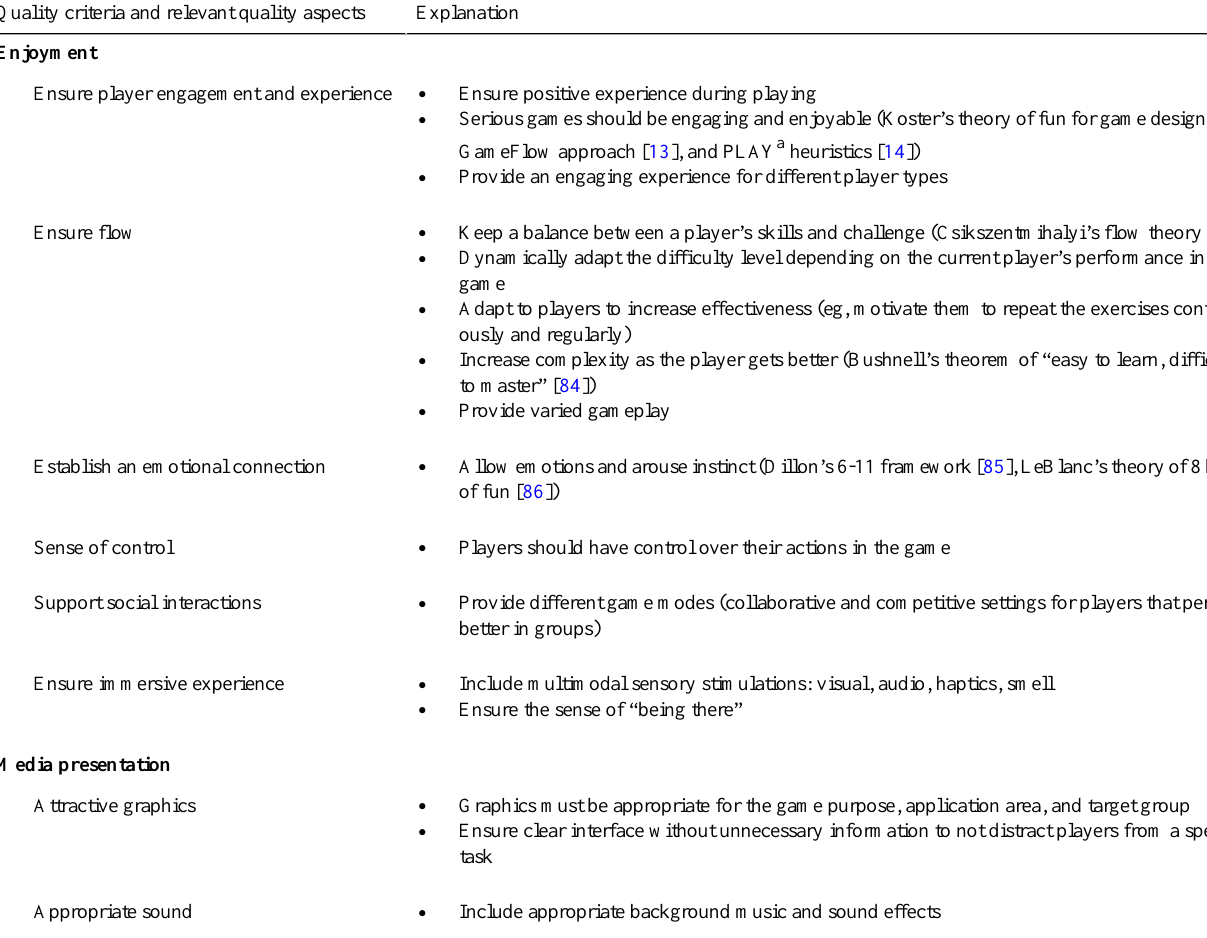
Table 2. Summary of quality criteria for the game part. ExplanationQuality criteria and relevant quality